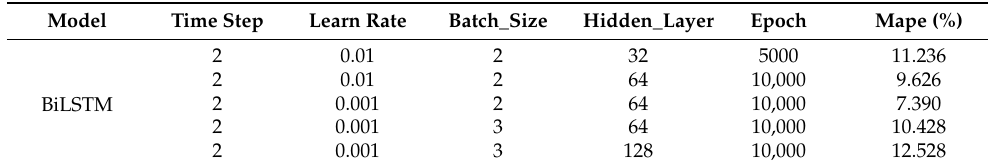
Table 4. Parameter setting for the BiLSTM neural network.